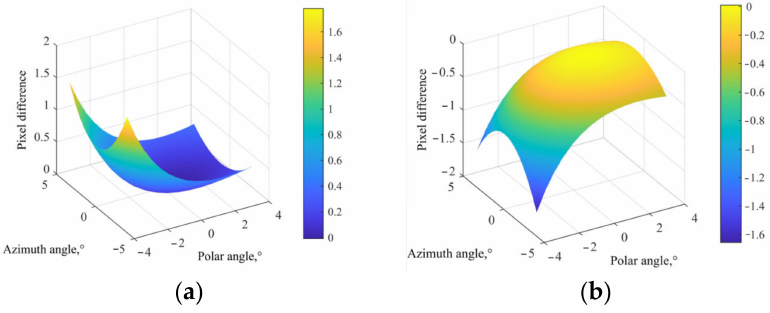
Figure 5. The accuracy of the simulation ( a ) α = 6.3 ◦ ( b ) α = 6.7 ◦ .